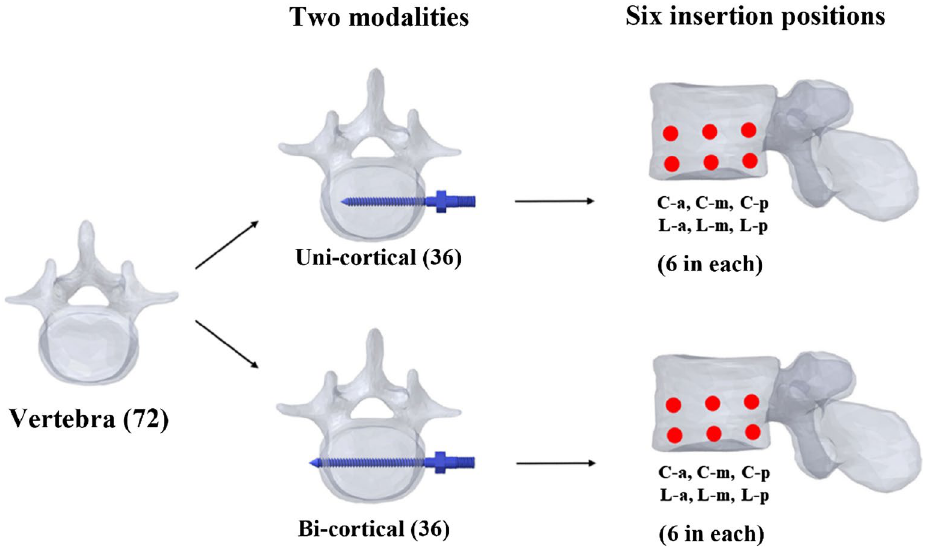
Figure 10. Allocation of the specimens to experimental groups. A total of 72 porcine vertebrae were used. Thirty-six of the 72 porcine vertebrae were randomly designed to the unicortical fixation modality, and the other 36 were randomly designed to the bicortical fixation modality; 6 specimens were used in each